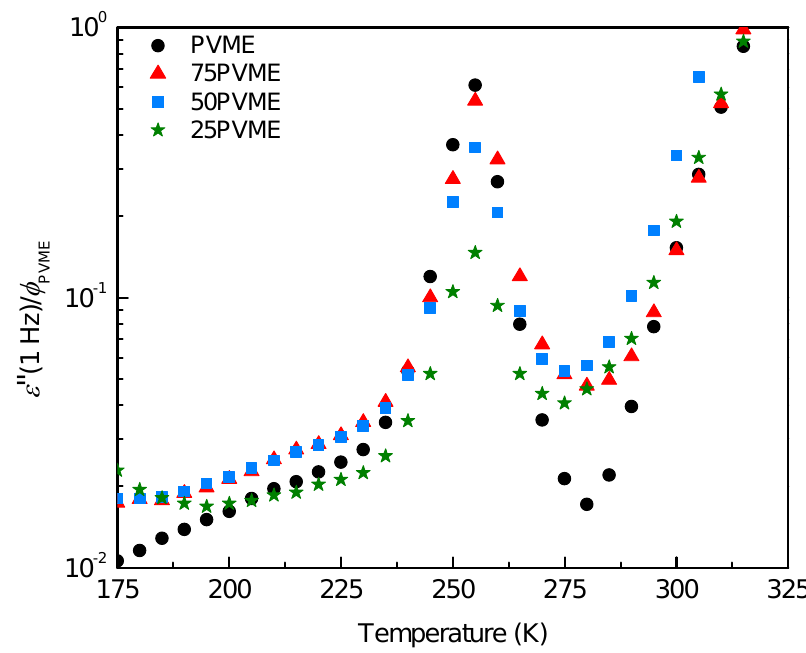
Figure 3. Loss component ε (cid:48)(cid:48) ( T ) of the complex dielectric permittivity obtained at 1 Hz as a function of temperature for pure PVME and PVME/SCNP mixtures with various compositions ( φ PVME = 75, 50, and 25 wt%). For each sample, the ε (cid:48)(cid:48) values are divided by the PVME weight fraction φ PVME